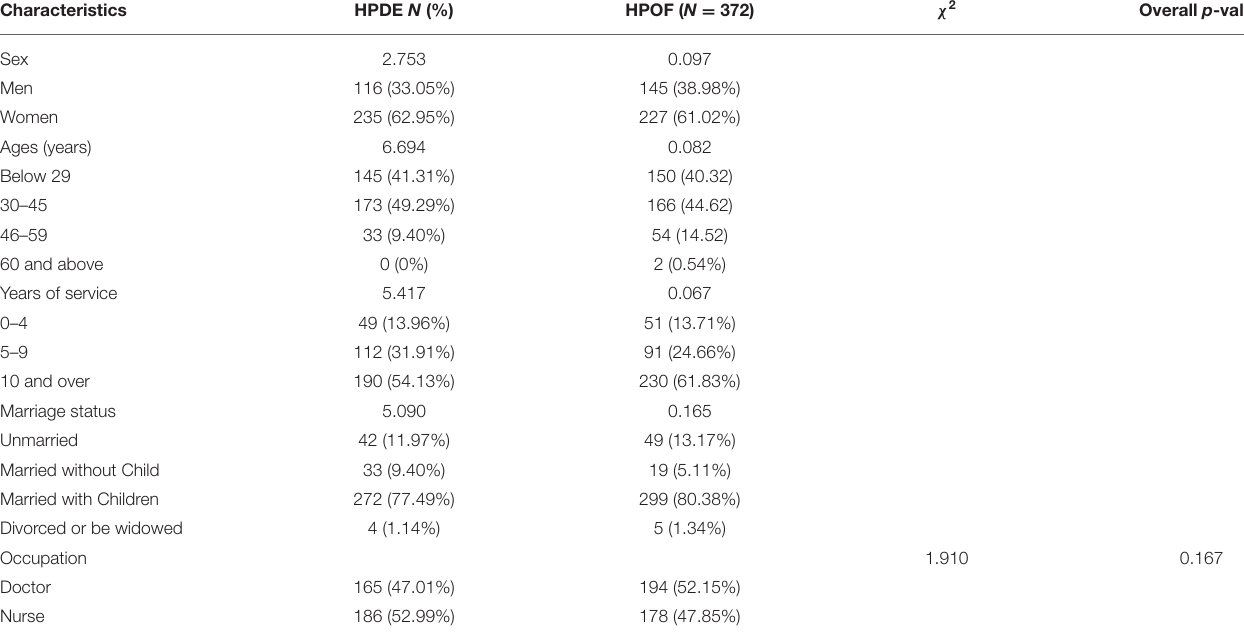
TABLE 1 | Characteristics of respondents.